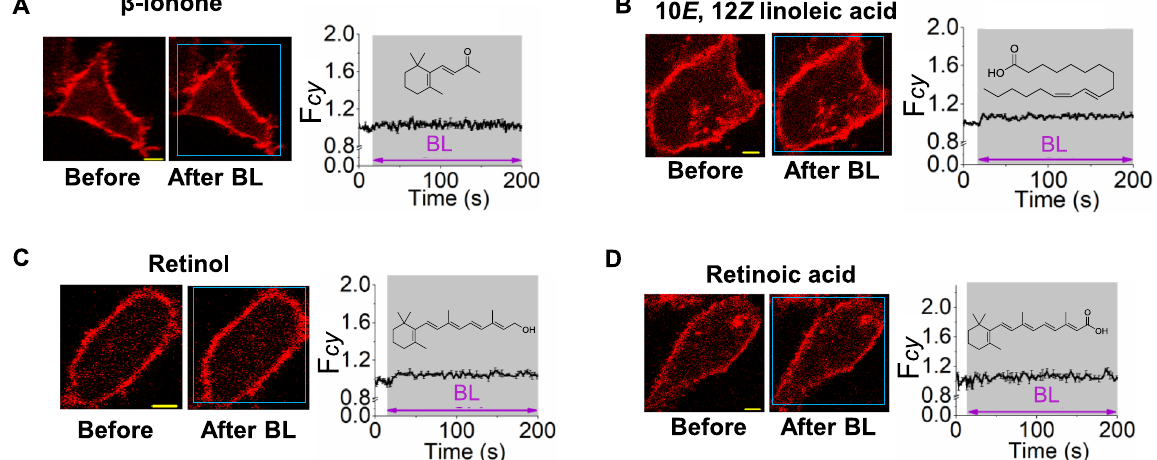
Figure 4. Retinal-like molecules exhibited no effect on PIP2 upon blue light exposure. Images of HeLa cells expressing PIP2 sensor (mCherry-PH) on PM. In all of the experiments conducted, cells were exposed to blue light (4.86 µ W of 445 nm) which is indicated by the white box. Cells were incubated with ( A ) β -ionone (50 µ M), ( B ) 10 E , 12 Z linoleic acid (50 µ M), ( C ) Retinol (50 µ M) and ( D ) Retinoic acid (50 µ M), for 10 minutes followed by continuous exposure of short pulses of blue light for 200 s. In all experiments, cells did not show a detectable PIP2 sensor translocation. Plots show the dynamics of PIP2 sensor translocation in cells shown in A – E . (mean ± S.E.M., n = 5–10 cells). Mean and S.E.M. are from 3 < independent experiments. (blue light (BL) = blue box). Scale = 5 µ